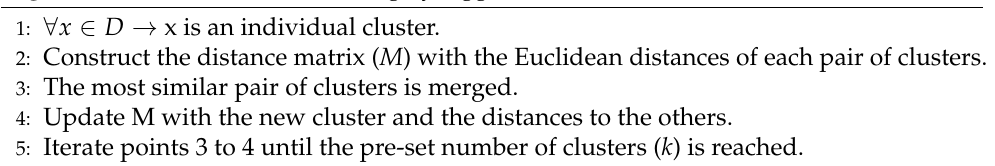
Algorithm 2 Hierarchical Clustering by Agglomeration